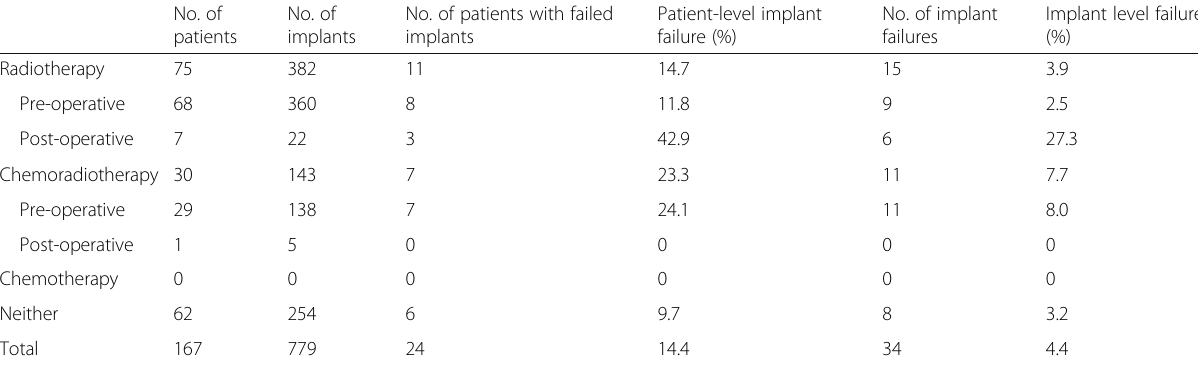
Table 5 Use and timing of radiotherapy, chemotherapy and implant failure No. of patients